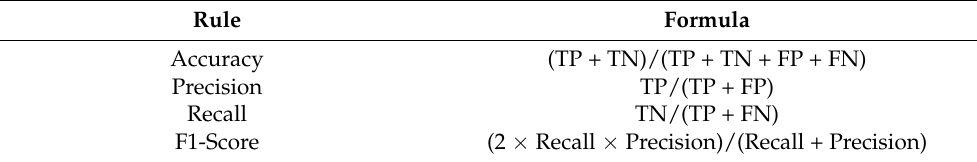
Table 6. Performance